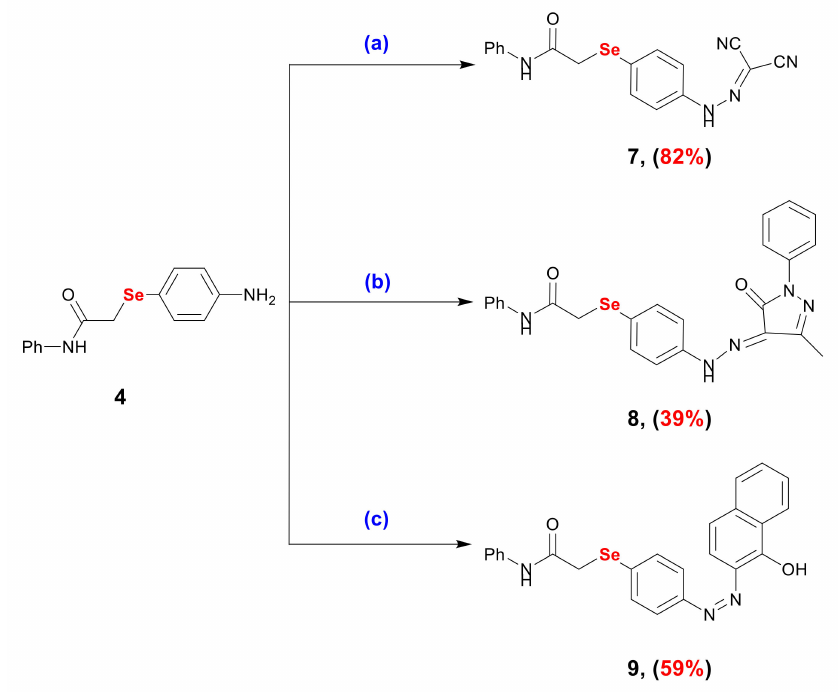
Scheme 2. Synthesis of selenide-based azo compounds. Reagents and conditions: Amine 4 (1 mmol),